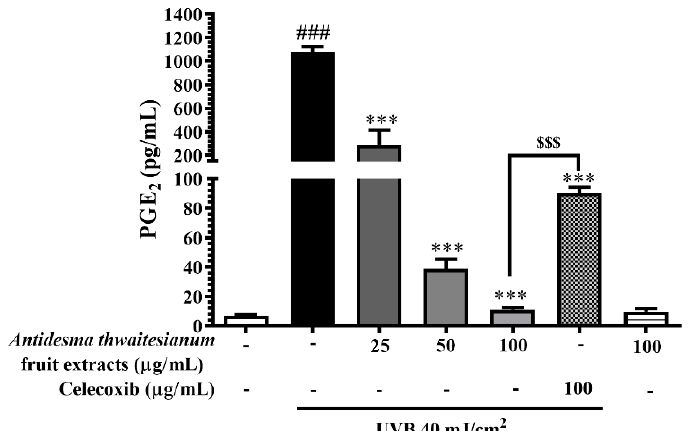
Figure 8. The dose-dependent effects the fruit extract on PGE 2 level. Cells were pre-incubated with the fruit extract for 2 h before exposure to single UVB irradiation and further incubated for 24 h. The cell culture media were used to determine the PGE 2 level by ELISA assay. The results are represented as mean ± SEM (n = 6) and analyzed with Tukey’s test. ### p < 0.001 versus the control group, *** p < 0.001 versus UVB-irradiated cells alone. The statistical difference between the extract and celecoxib at 100 µ g/mL was $$$ p <